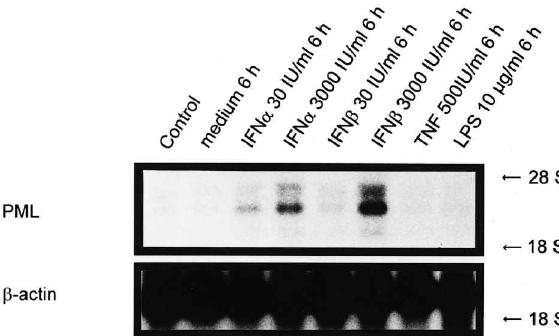
FIG. 1. Induction of PML mRNA by interferon. Northern blot analysis of PML-specific mRNA levels from IFN-treated and untreated PBMNC. PBMNC were treated with the indicated dose of IFN- a , IFN- b , TNF- a or LPS for 6h. Medium treated PBMNC and freshly isolated PBMNC without further incuba- tion were included as controls. Size fractionated total cellular RNA (20 m g per lane) was blotted and hybridized to the indicated 32 P-labelled cDNA probes. For quantitative analysis of mRNA levels densitometric scanning of autoradiographs was applied as described in Materials and